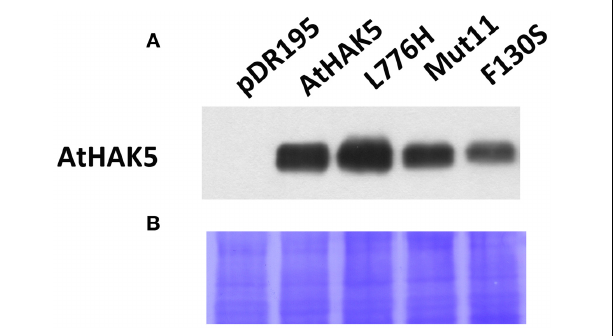
FIGURE 7 | Detection of the AtHAK5 WT and mutated proteins expressed in yeast by Western blot. The yeast strains described in Figure 1 were grown overnight in YPD media supplemented with 100mM K + . Then, proteins of the total membrane fraction were isolated, resolved on polyacrylamide gel and transferred to a PVDF membrane for AtHAK5 detection by Western-bolt. A polyclonal antibody raised in rabbit against the YGYKEDIEEPDEFE peptide of AtHAK5 was used. (A) Shows the immunological detection of AtHAK5 in the different yeast strains. (B) Shows the coomasie blue staining of the hybridized PDVF